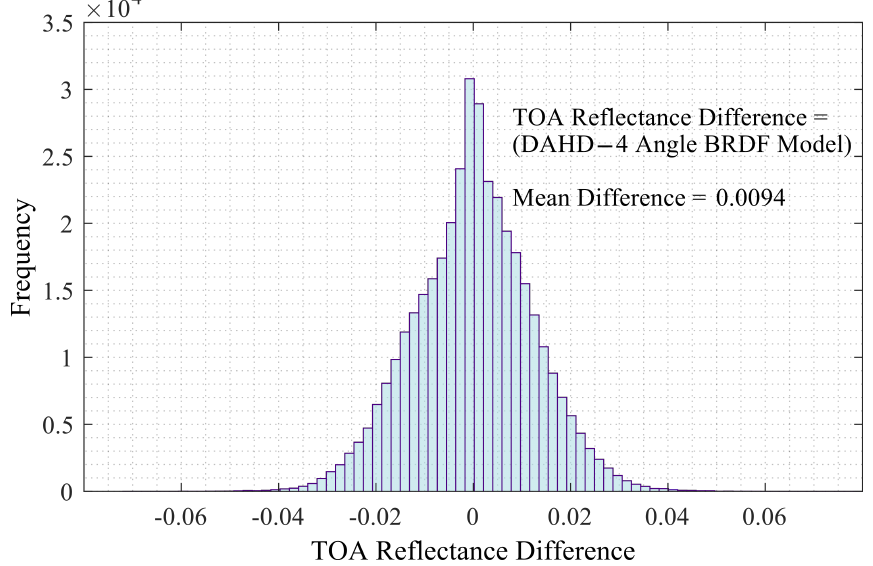
Figure 17. TOAreflectance differences between DaHDvs. 4-angle hyperspectral BRDFmodel for 196